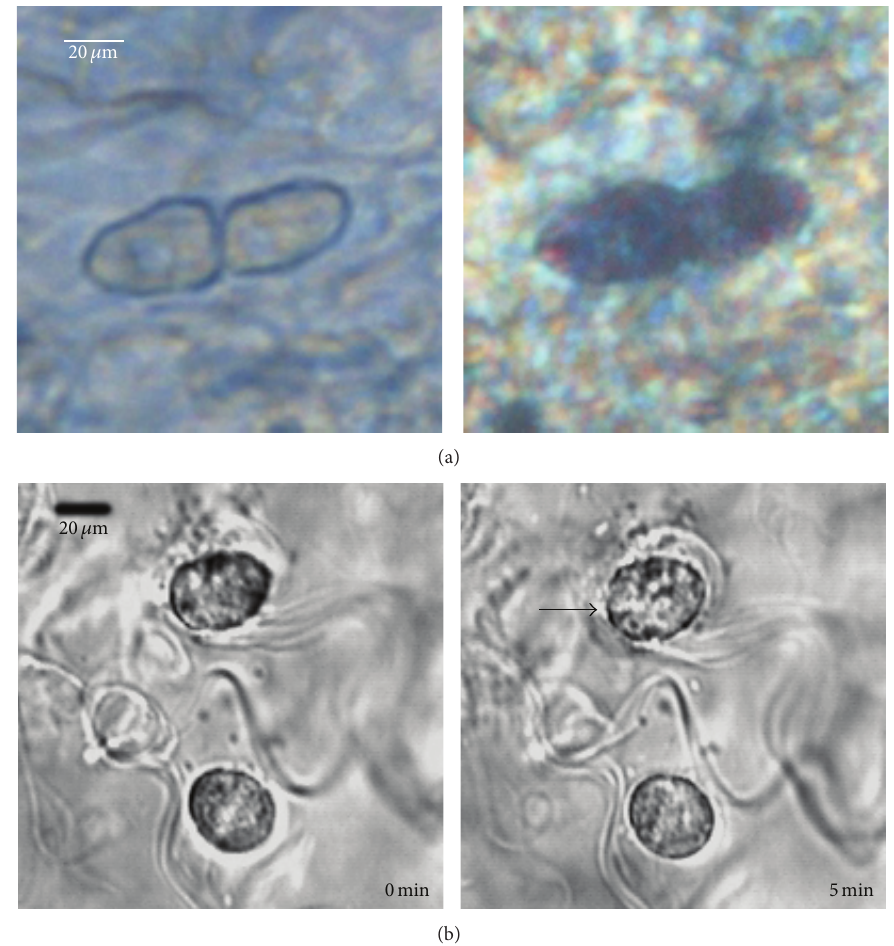
Figure 4: Response of MCs in rat tissue slices to 657 nm and 0.28 W/cm 2 laser irradiation. (a) MCs in connective tissue slices isolated from rat skin. The left graph shows their smooth and complete plasma membrane. The right graph presents the same MCs stained by 0.5% TB. (b) MCs in tissue slices showed smooth cell membranes before irradiation (left graph). Some MCs started to degranulate once they were exposed to irradiation. The cell membrane became rough, and some black granules were seen scattered around the cell (right graph). The arrow points to degranulating cell. Irradiation times are given in the lower right